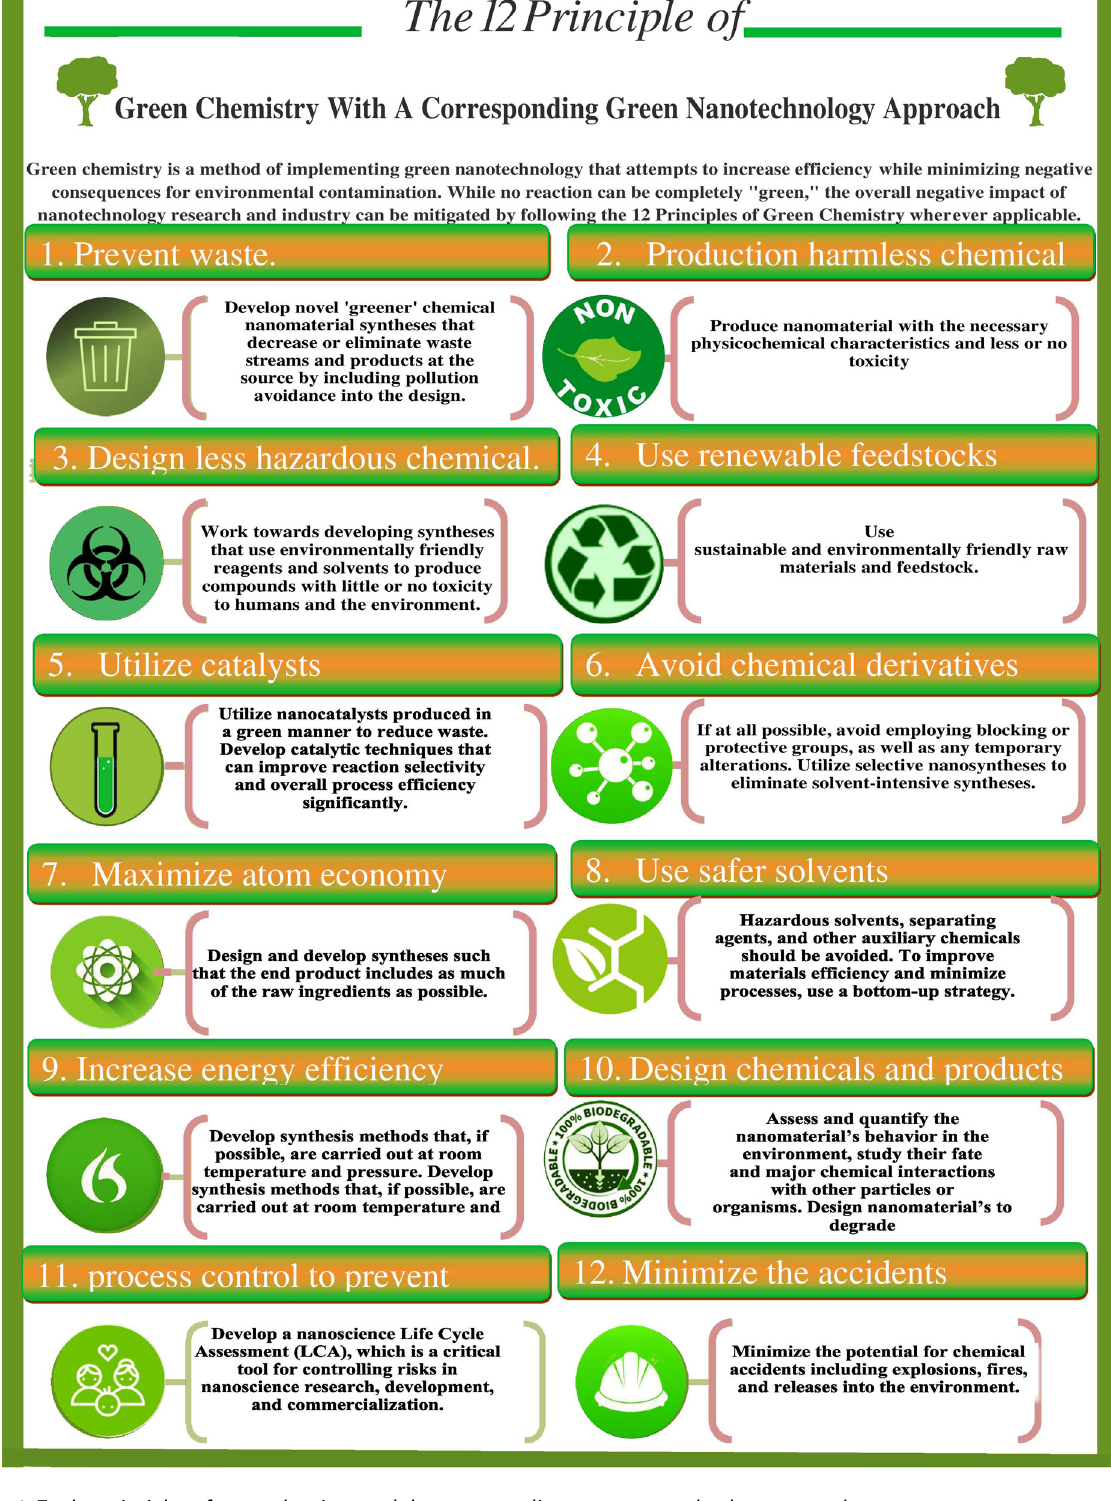
Figure 1: Twelve principles of green chemistry and the corresponding green nanotechnology